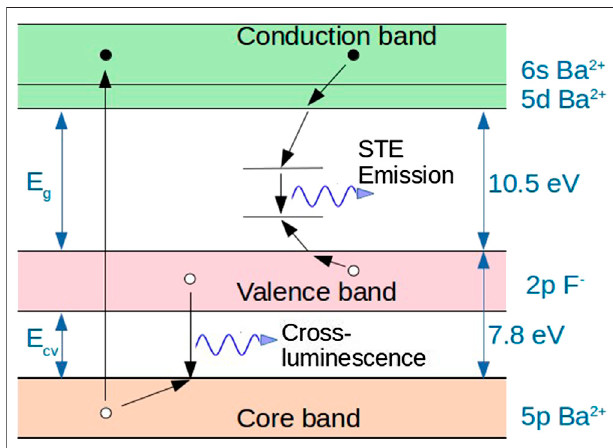
FIGURE 1 | Schematic overview of the band-gap diagram of BaF 2 and corresponding emission mechanisms, based on ref.